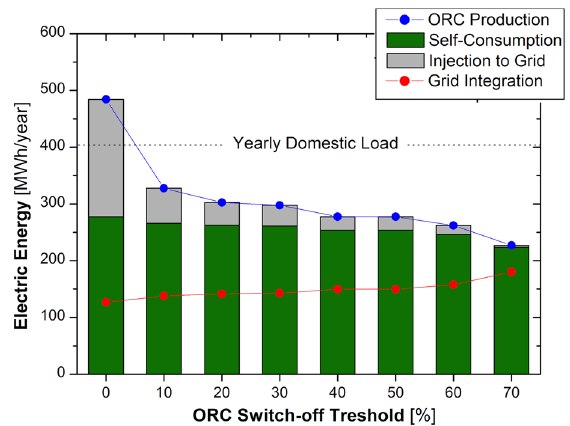
Figure 14. Influence of the ORC switch-off value on the yearly electric balance. ORC production (self-consumption and injection quota) and grid integration.